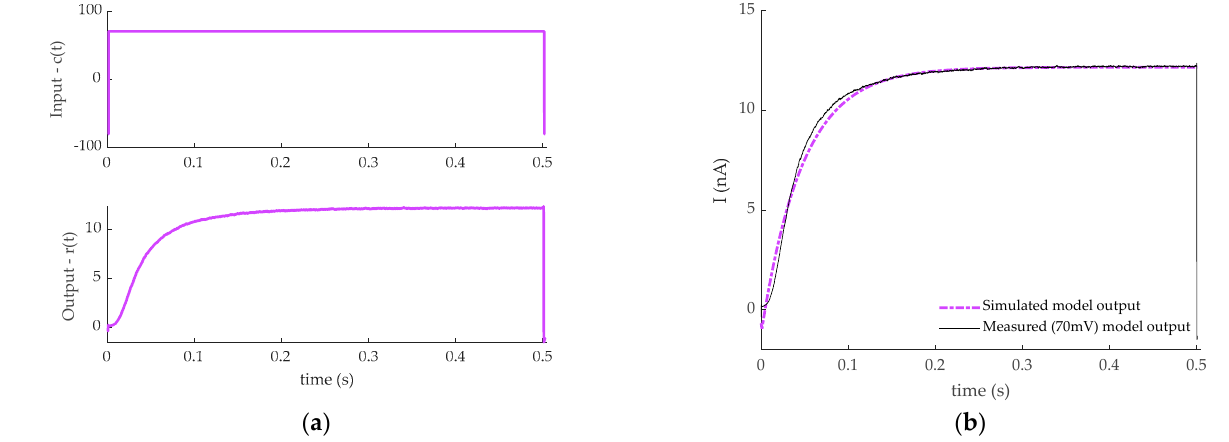
Figure 5. Input-output data for nominal operating point at 70 mV ( a ); output: macroscopic ion current ( b ) used for system identification.